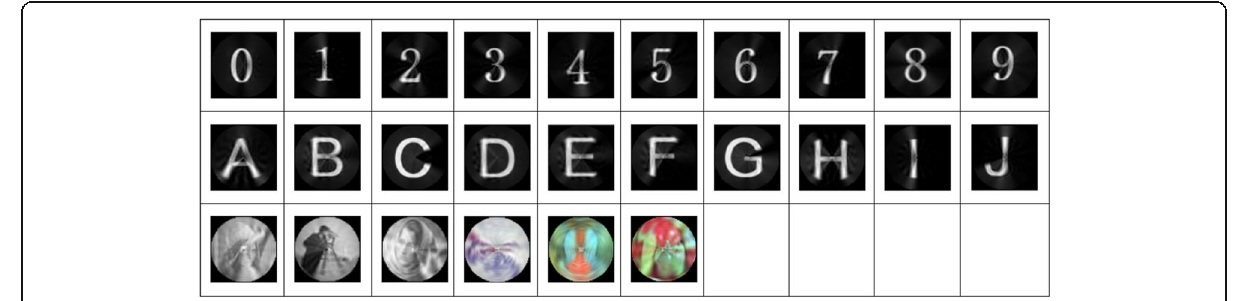
Fig. 8 Images reconstructed from the proposed modified exponent-Fourier moments up to order